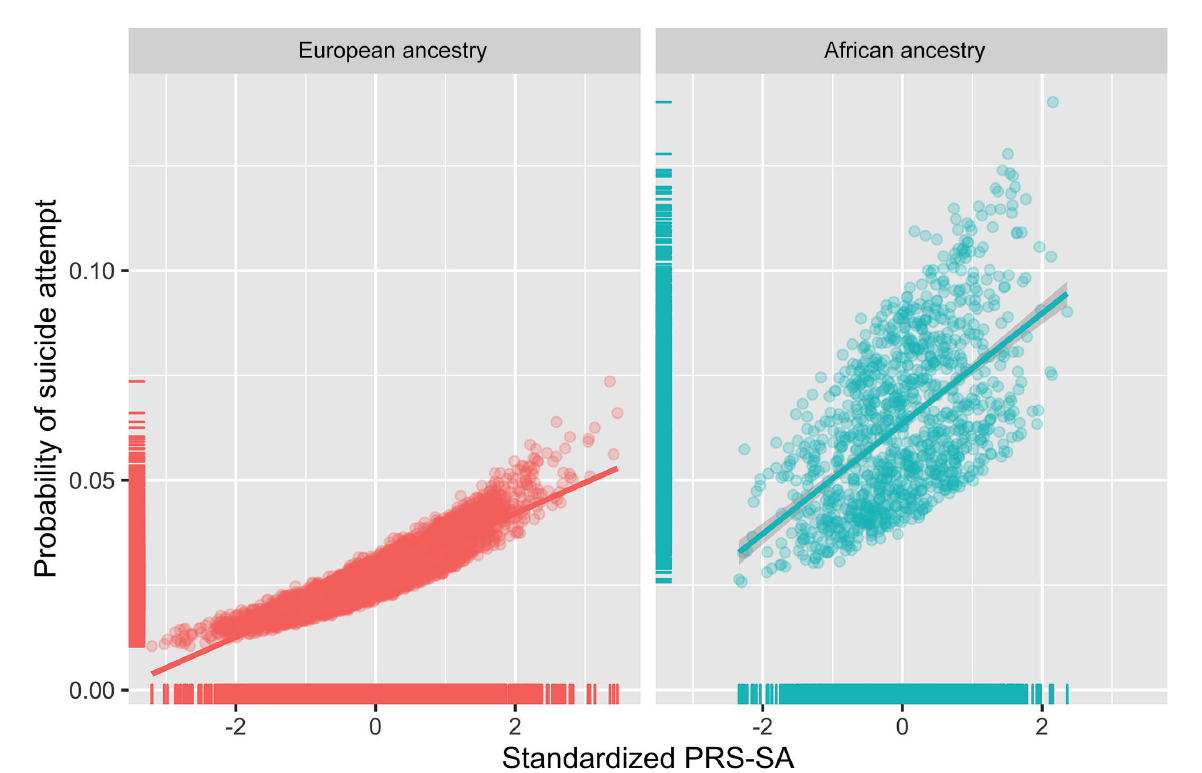
FIGURE1 A polygenic risk score for suicide attempt (PRS-SA) and suicide attempt among youth of African and European ancestries. Scatter plots and regression lines show estimated probabilities of suicide attempt in adolescents obtained from binary logistic regression models with PRS-SA, age, and sex as independent variables. X-axis represents a PRS-SA score (after standardizing the raw PRS produced at a GWAS P -value threshold of 0.05 and then regressing out the first ten within-ancestry genetic ancestry principal components). Y-axis represents predicted probability of suicide